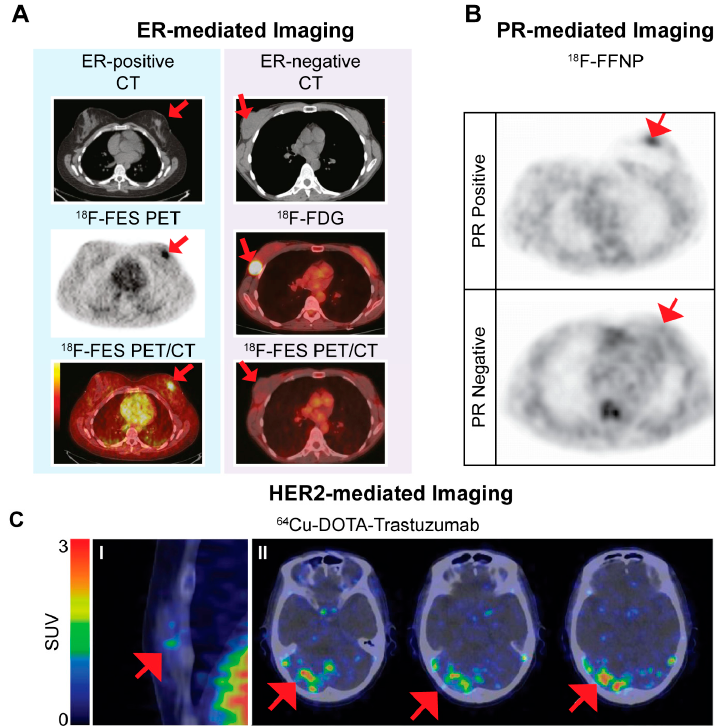
Figure 2. Examples of images using the estrogen receptor (ER)-targeted radiotracer 18 F-FES ( A ); progesterone receptor (PR)-targeted radiotracer 18 F-FFNP ( B ) and the human epidermal growth factor receptor 2 (HER2)-targeted radiotracer 64 Cu-DOTA-trastuzumab obtained in breast cancer (BC) patients. Images are adapted from Gemignani et al. [17], Dehdashti et al. [27] and Tamura et al. [31], respectively. ( A ) 18 F-FES PET images of an ER-positive and an ER-negative BC lesion. The ER-positive BC lesion visualized by 18 F-FES PET corresponds with a 2–3 cm lesion seen on CT and is confirmed on the 18 F-FES PET/CT images. The ER-negative BC lesion is visualized on CT and by 18 F-FDG PET but shows no 18 F-FES uptake. This research was originally published in JNM. Gemignani et